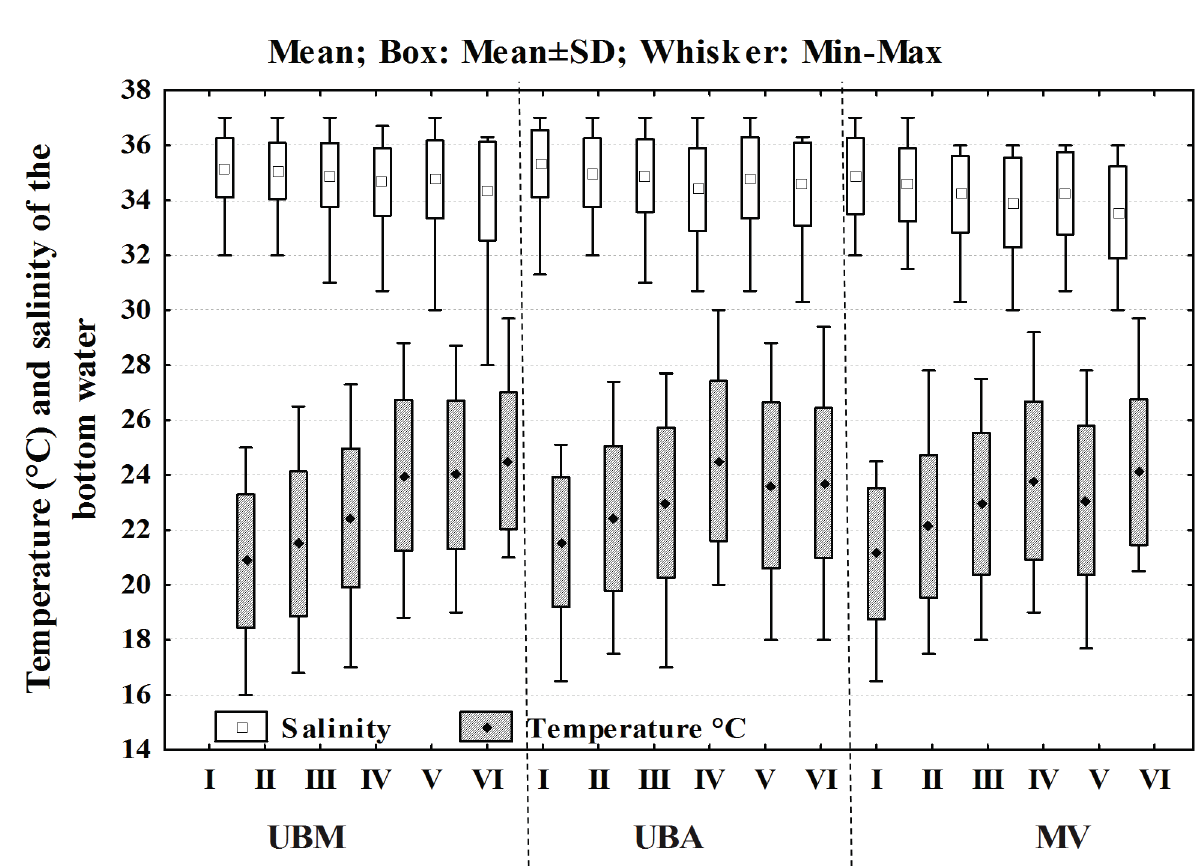
Figure 3. Mean values (minimum and maximum) of salinity and temperature (°C) of bottom water sampled from January 1998 to December 1999, at each sampling station, in the bays of Ubatumirim (UBM), Ubatuba (UBA) and Mar Virado